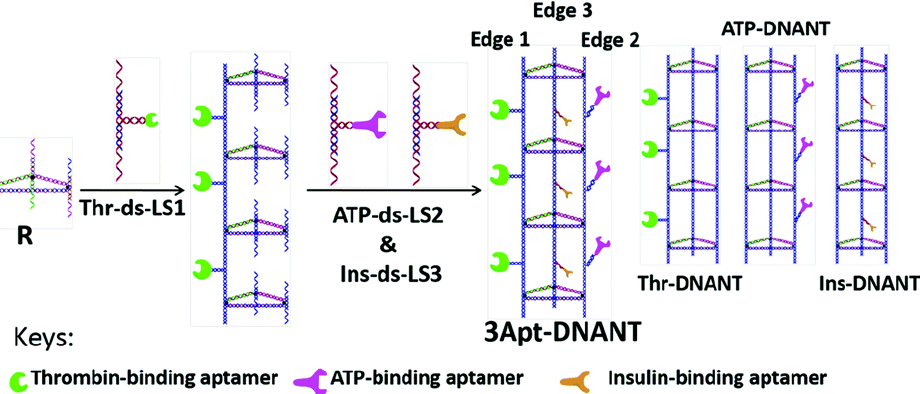
Figure 4. Schematic drawing of constructions of 3 aptamer-DNANTs and schematic representation of thrombin-DNANT, ATP-DNANT, and insulin-DNANT [91]. thrombin-DNANT, ATP-DNANT, and insulin-DNANT